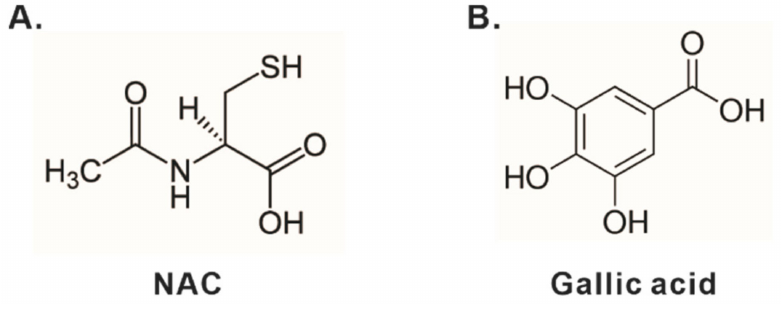
Figure 1. The structures of NAC ( A ) and gallic acid ( B